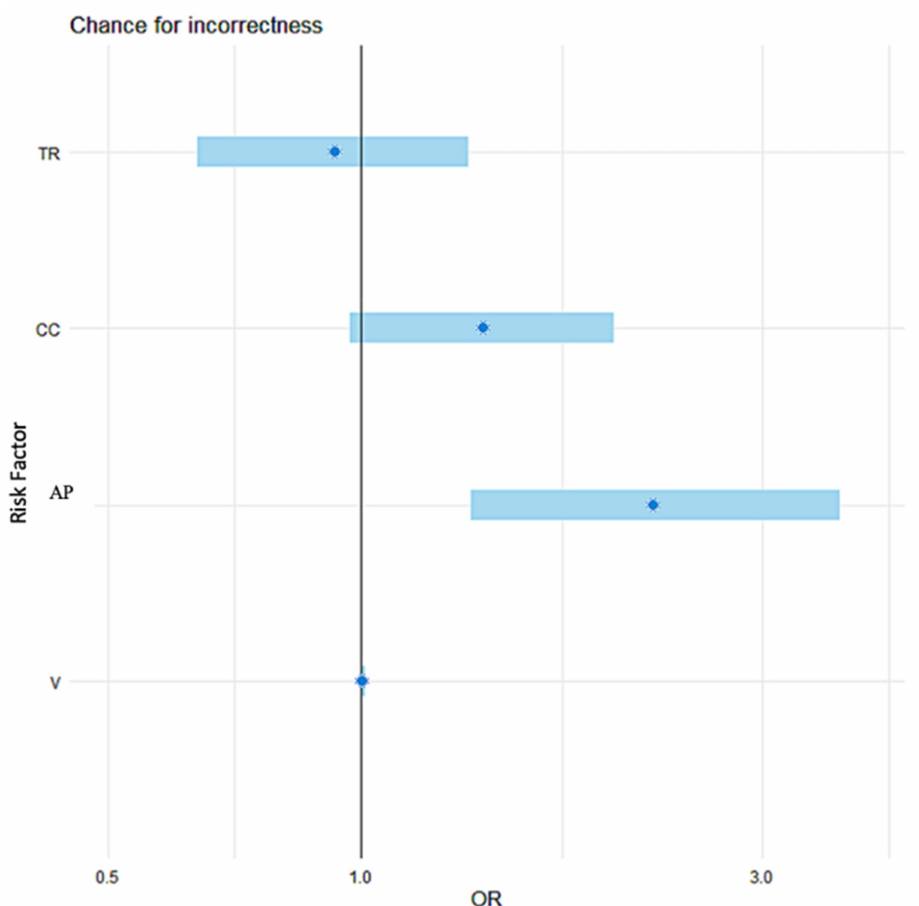
Figure 2. Logistic regression analysis showing advantage of the AP dimension over other geometric criteria determining the appropriateness of using contrast in pituitary MRIs. The forest plot of the odds ratios (OR) of a lack of correct diagnosis of pituitary lesions in a conventional MRI examination (common pre- and post-contrast sequences) includes the following risk factors: antero-posterior pituitary dimension (AP), cranio-caudal dimension (CC), transverse dimension (TR), and gland volume (V). The forest plot based on logistic regression analysis clearly shows that only the AP dimension, which does not cross the line of no difference (1.0 value), is statistically significant in contrast to the other dimensions (CC, TR) and gland volume